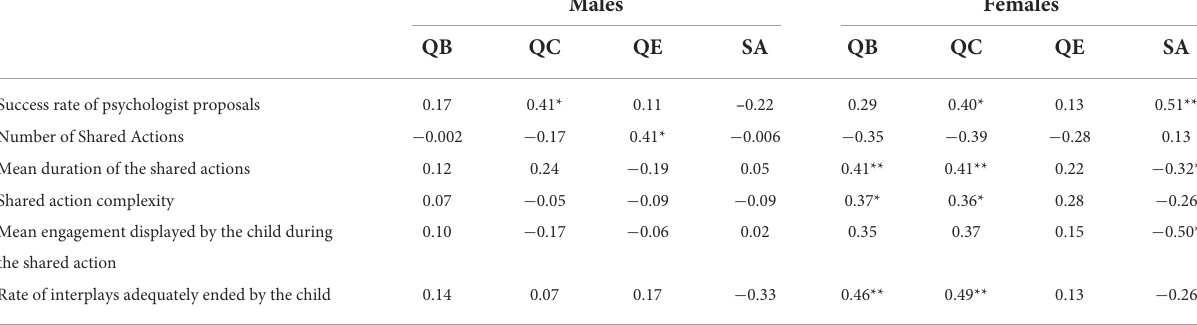
TABLE 5 Correlations among behavioral descriptors and clinical measures for the females and males